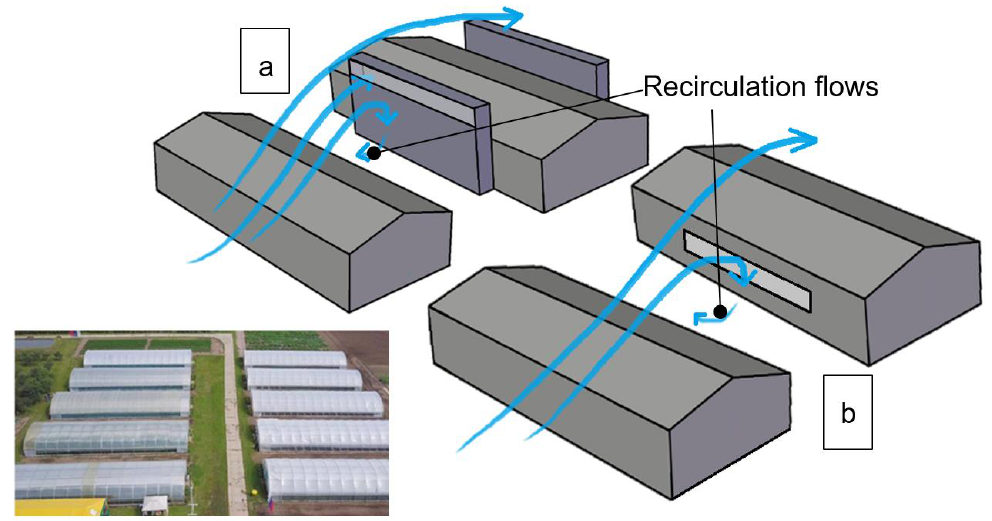
Figure 1. Schematic of a greenhouses with ( a ) windcatcher and ( b ) lower level openings surrounded by neighbouring greenhouses.